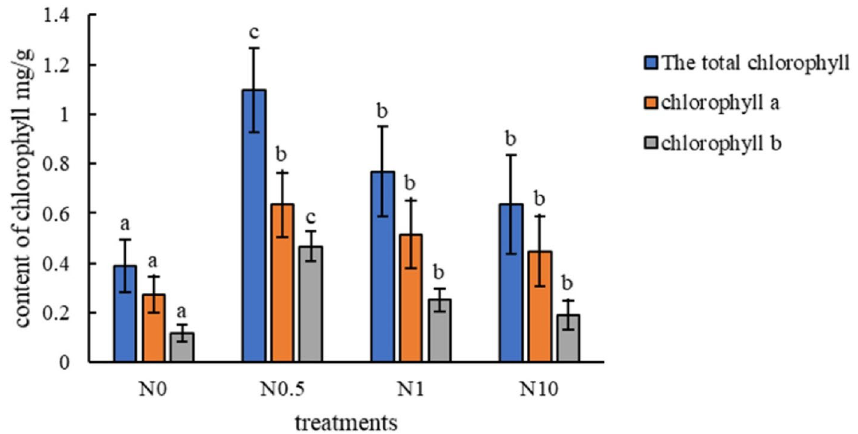
Figure 3. Chlorophyll content. The blue columns indicate the total chlorophyll content. The yellow and grey columns indicate the chlorophyll a and b levels, respectively. The letters a and b in all the figures represent significant differences, and error bars indicate differences between biological replications.